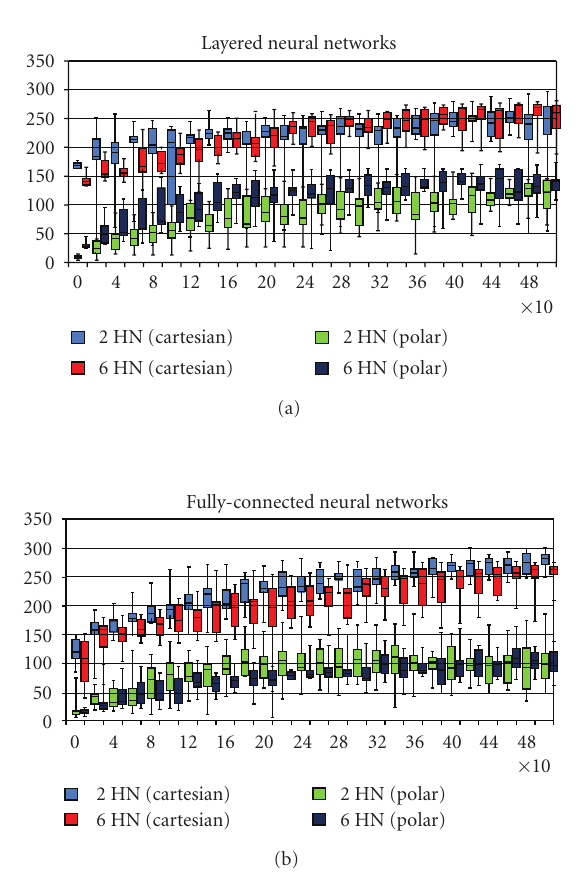
Figure 7: Box-and-whisker diagram of the repeated evaluation of di ff erent I/O models and di ff erent number of hidden neurons for layered and fully connected ANNs.